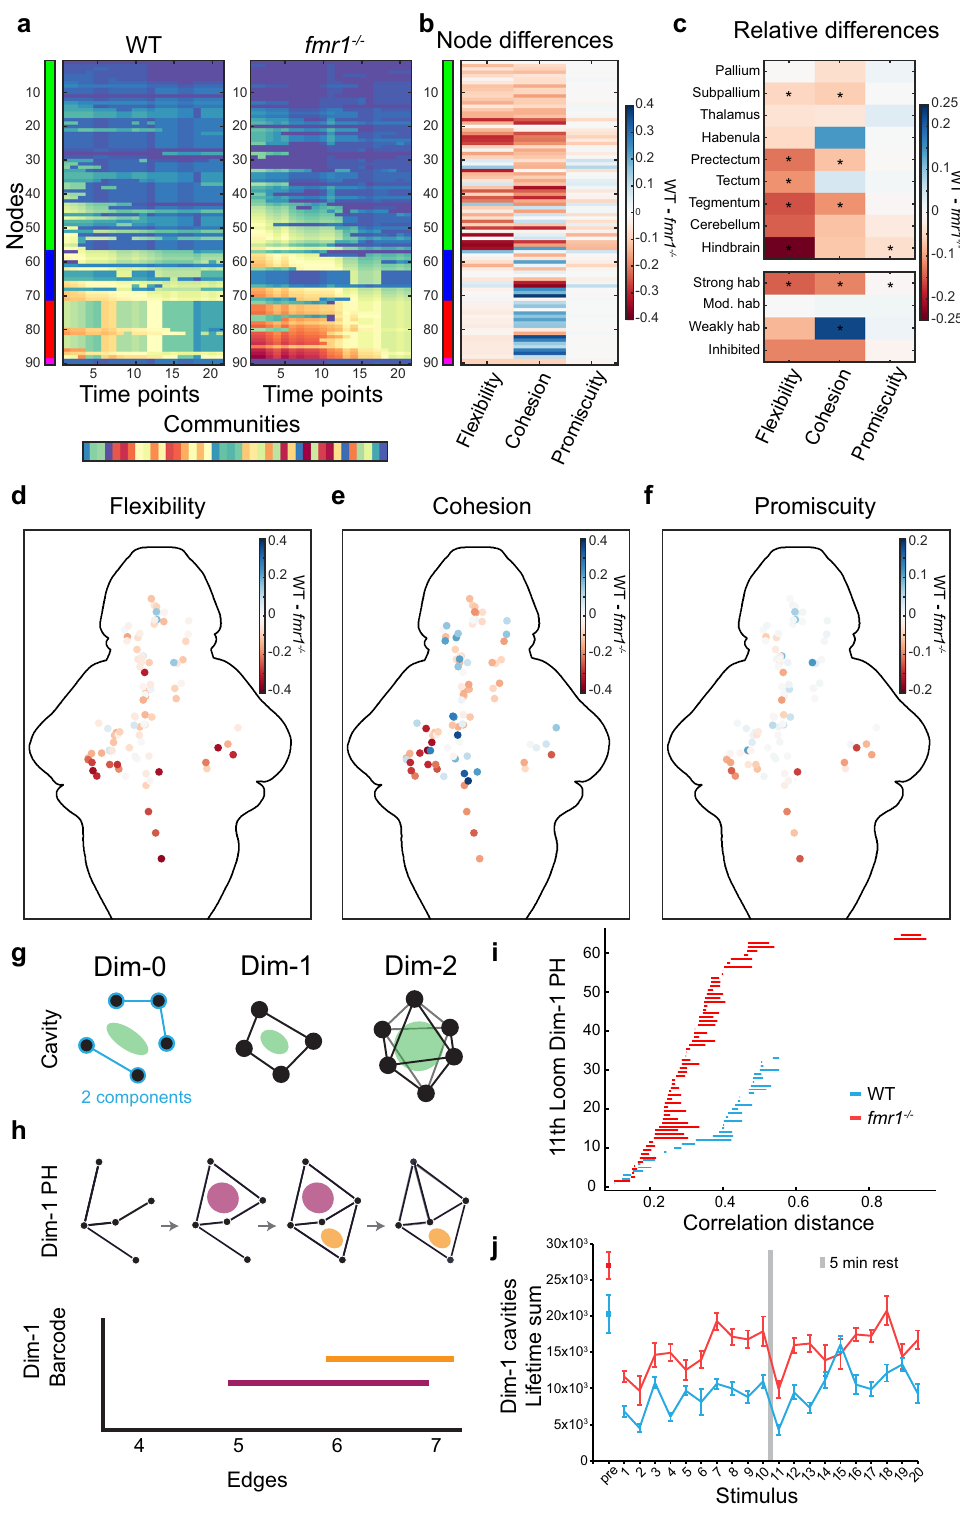
are upstream of the sensorimotor transformation that controls behavioral outputs. The regions most affected during habituation (especially the hindbrain, but also including a subset of ROIs in the thalamus and the pallium) are likely downstream of this